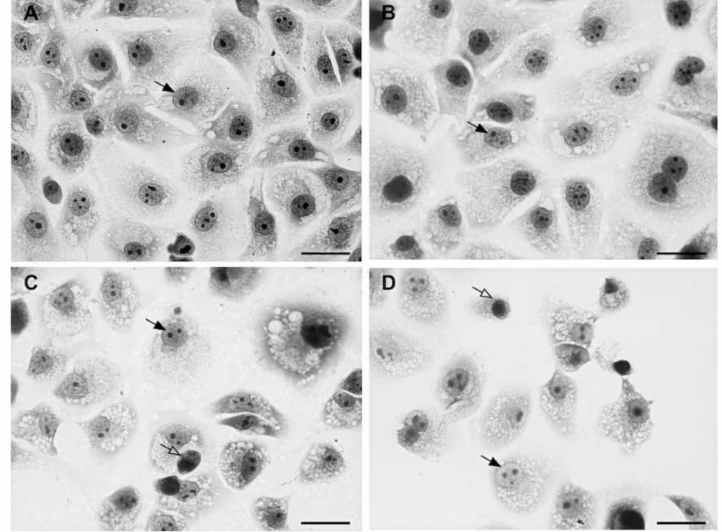
Figure 2. Toxicity in uninfected LLC-MK2 cells. The black arrow indicates nuclei with physiological appearance. White arrows indicate nuclear morphological changes indicative of toxicity. ( a ) Control case; In ( b – d ) a gradual increase of cytotoxicity is visible, associated with significant nuclear disorders and a decrease of the cellular